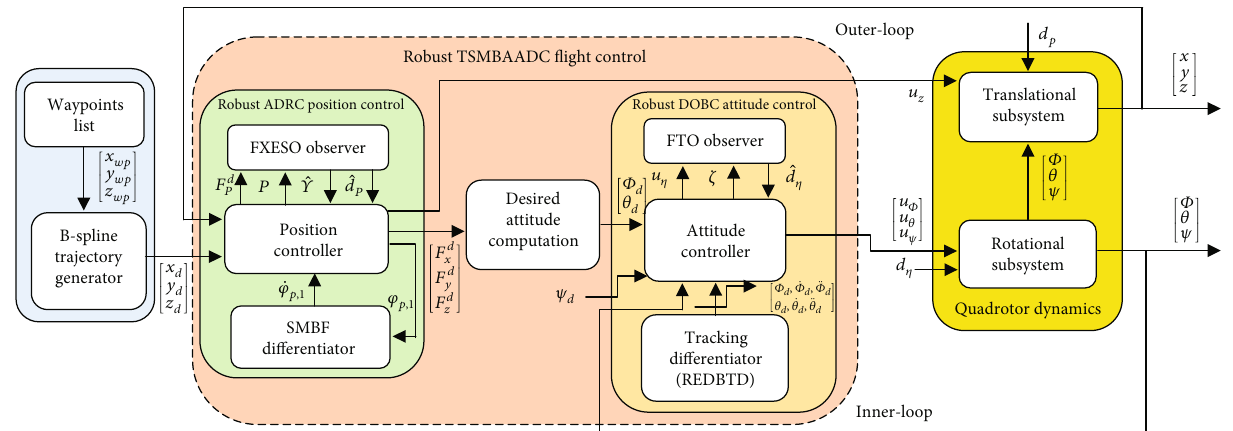
Figure 2: Block diagram of the quadrotor aircraft depicting the proposed fl ight control